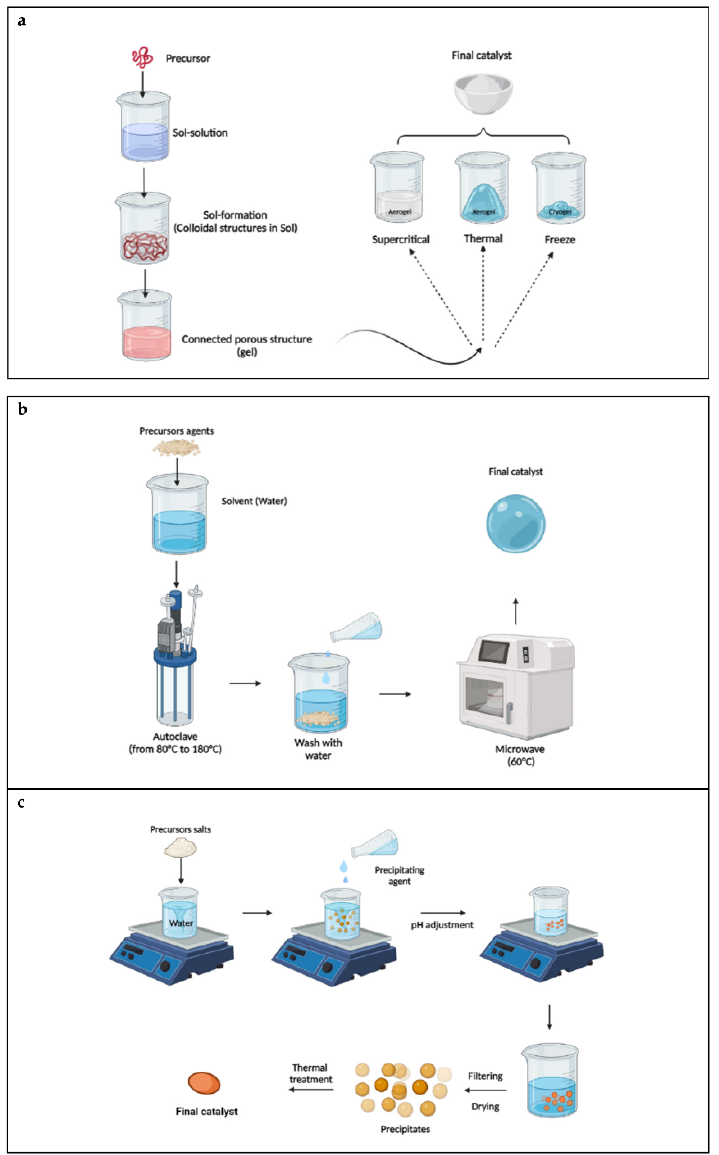
Figure 2. Schematic of different stages of ( a ) sol–gel process; ( b ) hydrothermal process; ( c ) precipita- tion method.